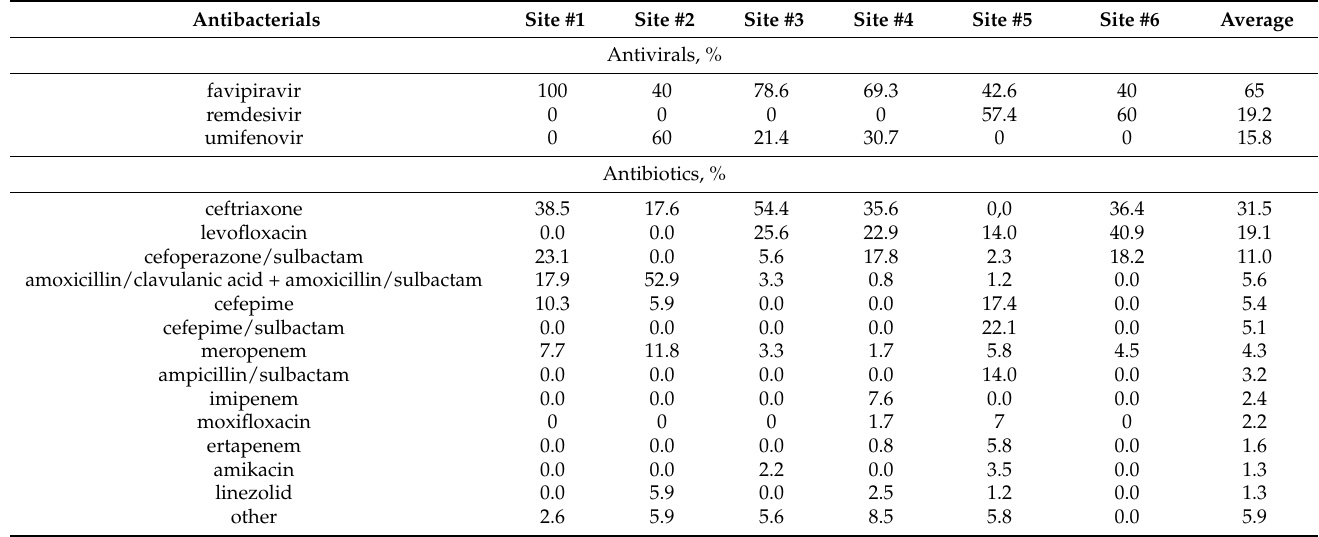
Table 4. Overall proportional use of systemic AMD (antibiotics and antivirals) for the treatment of patients with “COVID-19/pneumonia”, % of